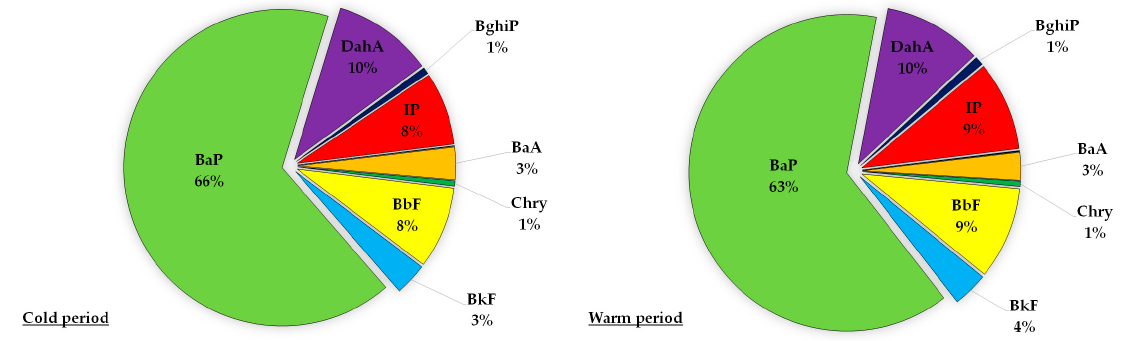
Figure 2. Contribution of individual PAHs to the total carcinogenic activity for PM 10 samples during the cold and warm periods. Contributions of Flu and Pyr were less than 1%.